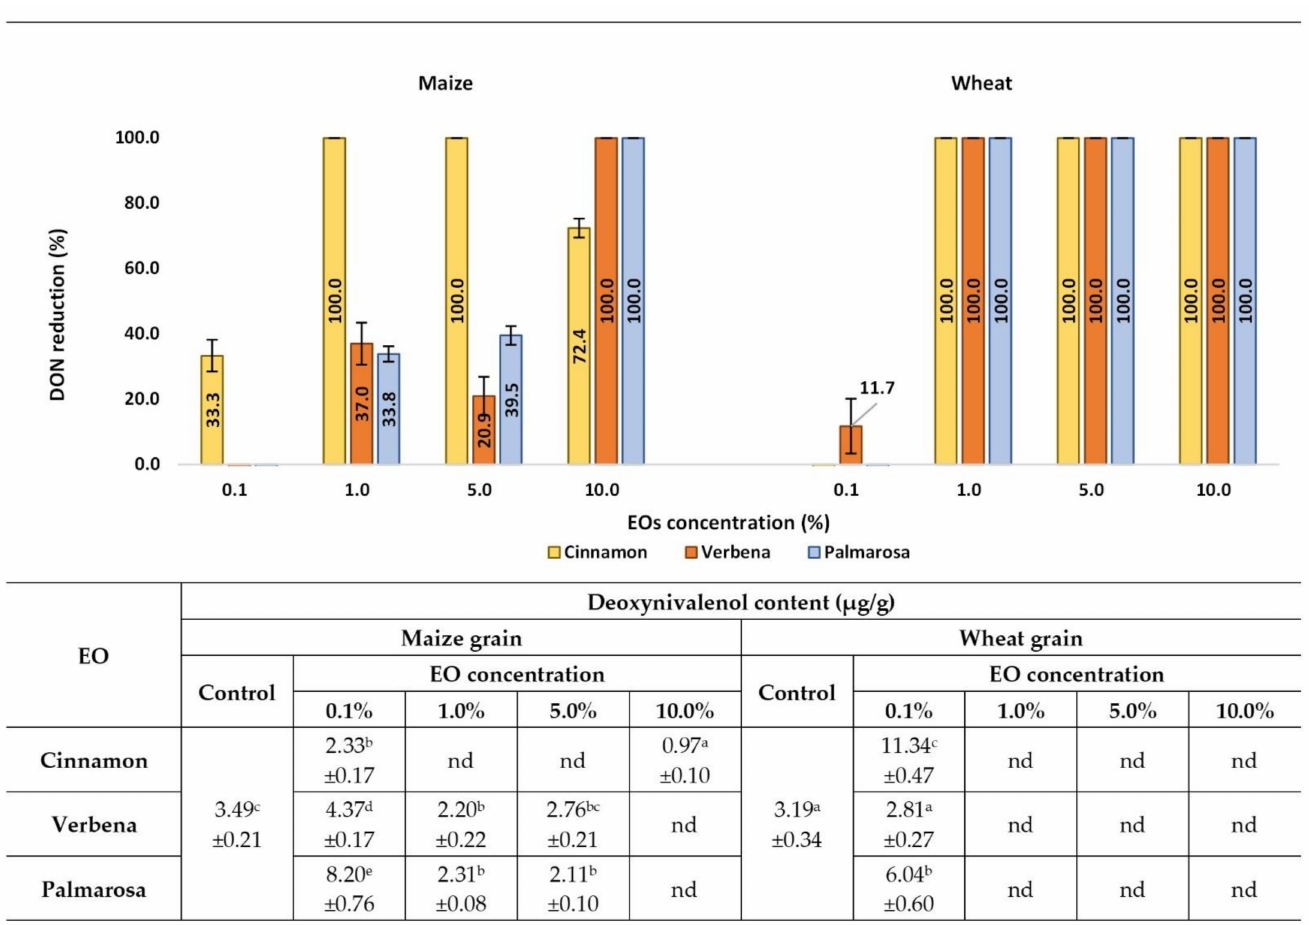
Figure 6. Effects of EOs on DON contamination in maize and wheat samples after inoculation with the F. graminearum . nd-not detected, below the limit of quantification (<0.01 µ g/g). Averages with different letters (a–e) for each cereal are significantly different at the p <